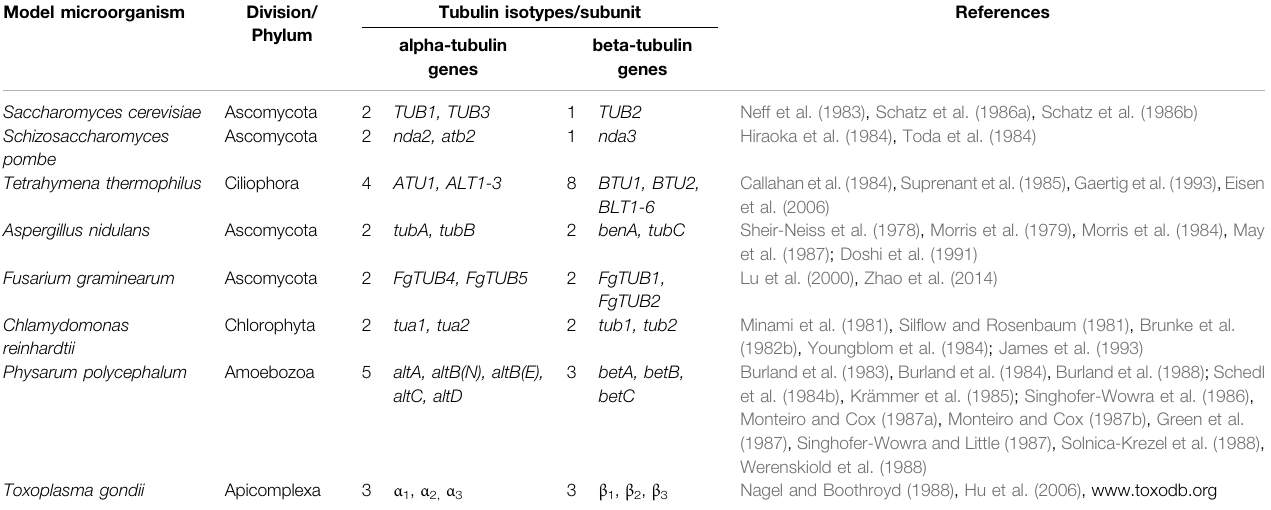
TABLE 1 | Multiple tubulin isotypes are expressed in model microorganisms* Model